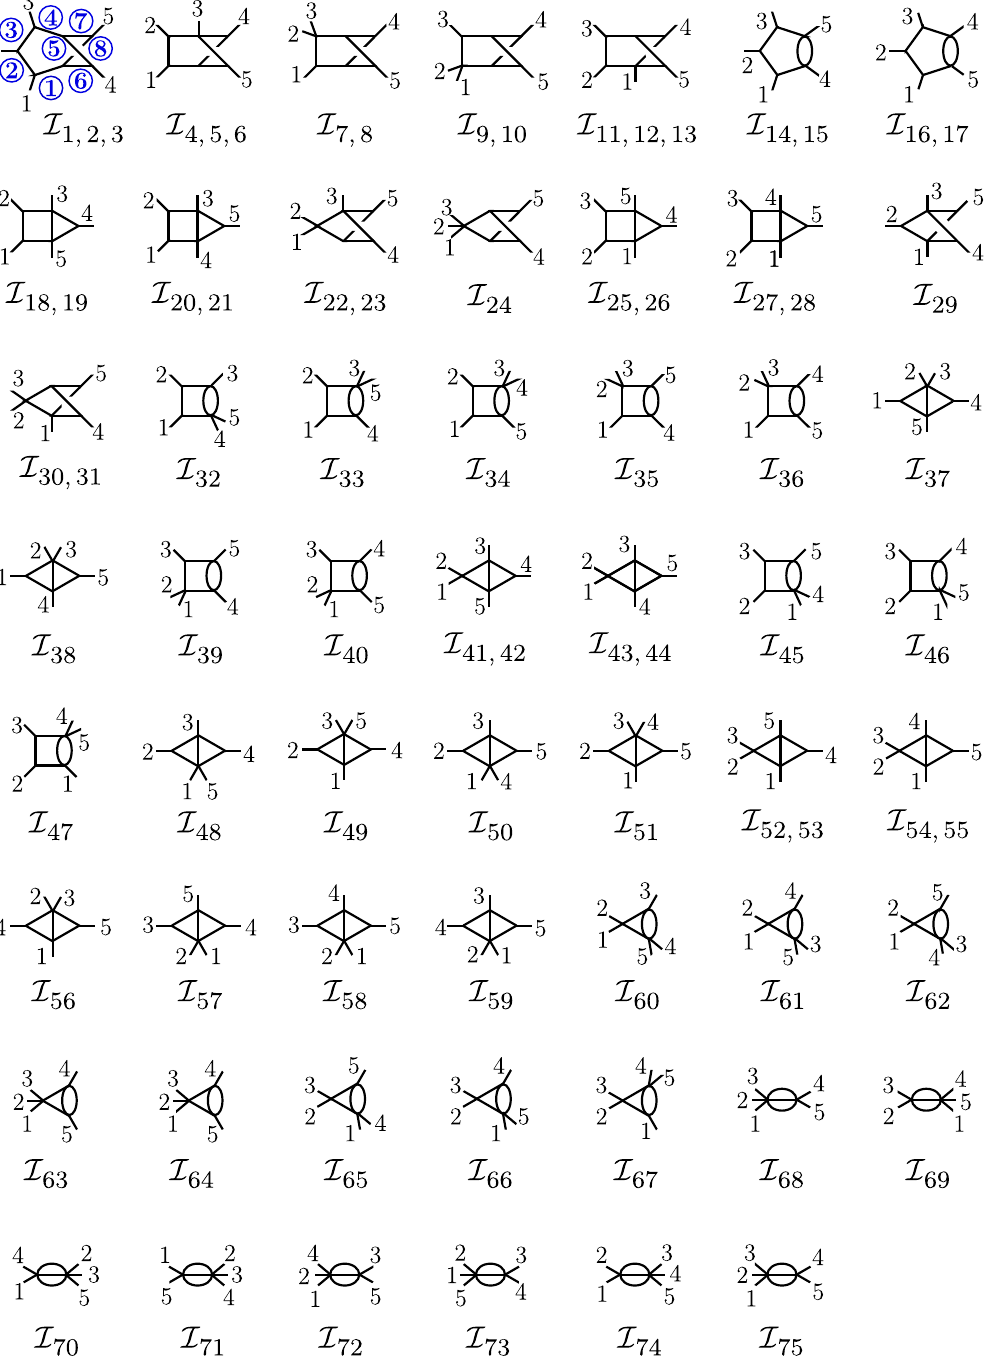
Figure 2 . (Color online.) The 75 \pre"-master integrals found by Azurite , with the global sym- metry option turned o(cid:11), for the non-planar hexagon-box family of eq. (5.2). By turning on the global symmetry option, Azurite determines that there are 73 master integrals. These are the illustrated \pre"-master integrals excluding I 63 and I 68 . Our labeling convention for the propaga- tors, corresponding to the indices recorded in eq. (5.3), are shown in the graph of the hexagon-box itself as the blue encircled numbers.